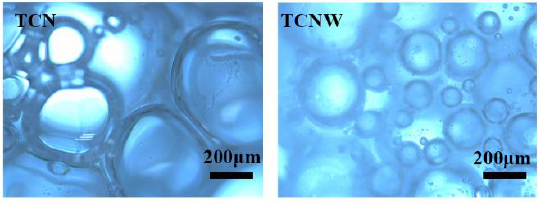
Figure 3. Optical micrographs of TCN- and TCNW-stabilized bubbles.